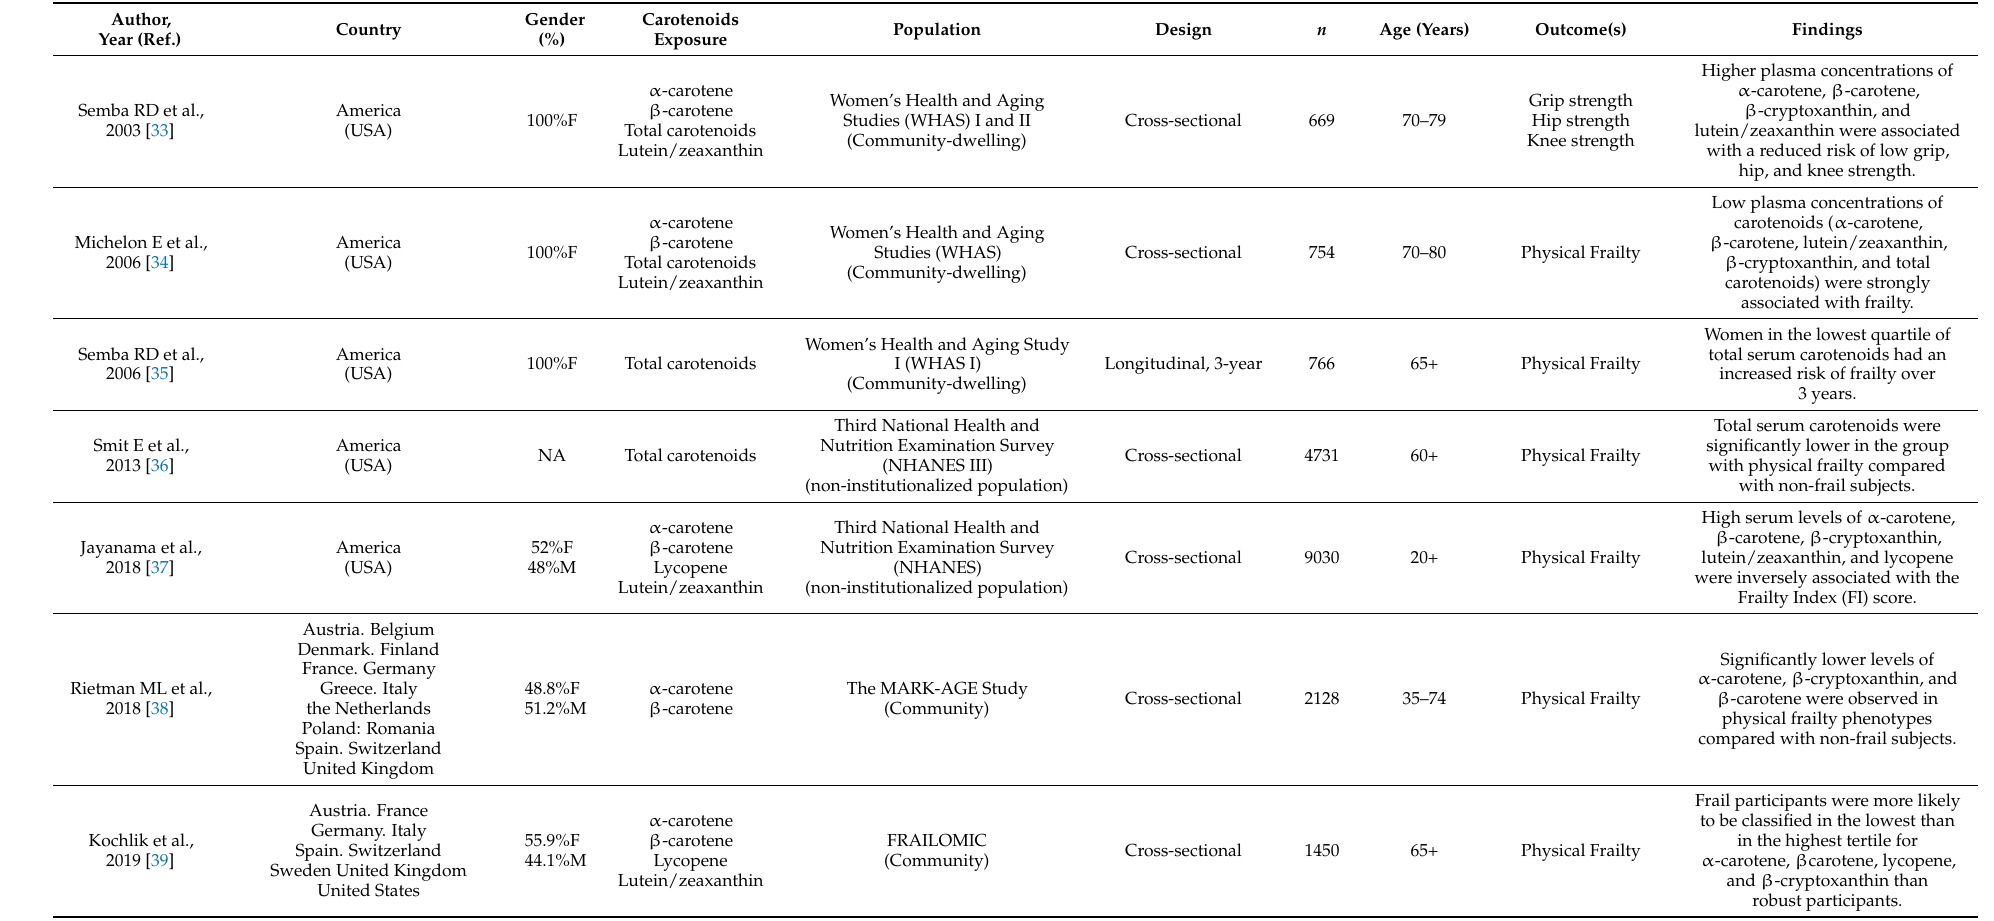
Table 2. Selected studies investigating carotenoids in relation to physical frailty ( n =